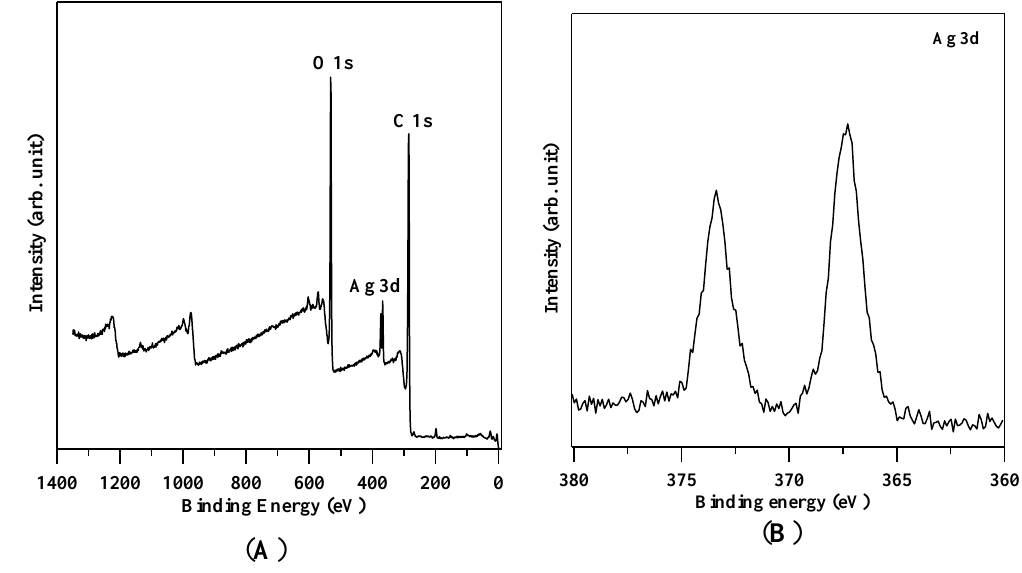
Figure 4. X-ray photoelectron spectrometer (XPS) patterns. (A) O/C ratio of reduced graphene oxide (GO) is 0.326; (B) Ag nanoparticles are deposited on GO.